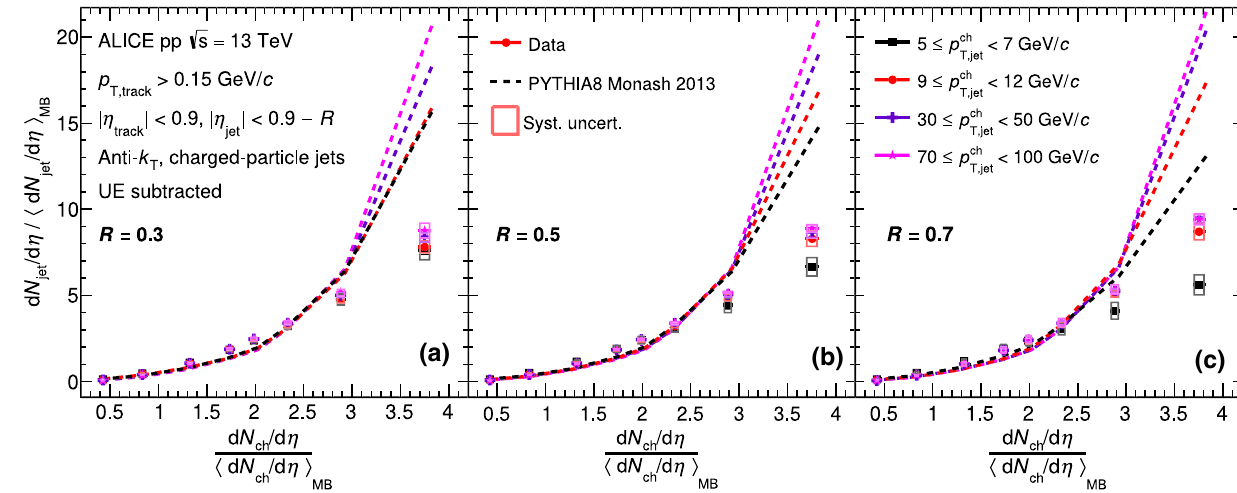
Fig. 14 Comparison of self-normalised jet yields as a function of predictions, with the charged-particle multiplicities provided in Ref. [66]. Statistical and systematic uncertainties are shown as vertical error the self-normalised charged-particle multiplicity in four selected jet < 7 GeV / c , 9 ≤ p ch < 12 GeV / c , 30 ≤ p T intervals (5 ≤ p ch bars and boxes around the data points, respectively. Results for other T , jet T , jet radii can be found in Appendix Fig. < 50 GeV / c , and 70 ≤ p ch < 100 GeV / c ) for a given jet radii: p ch T , jet T , jet R = 0 . 3 (a) , R = 0 . 5 (b) , R = 0 . 7 (c) between data and PYTHIA8